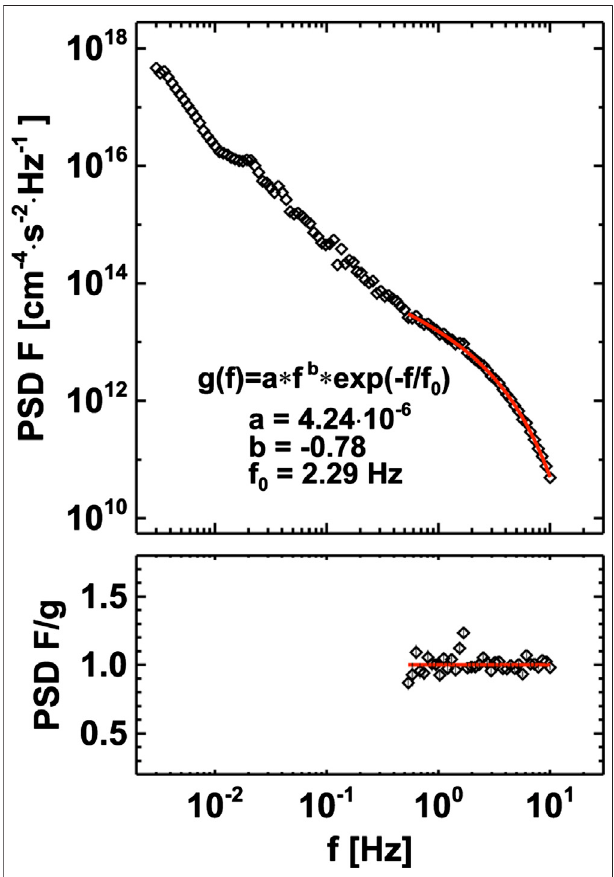
FIGURE 7 | Upper plot: The power spectral density of the ion fl ux downstream of a particularly strong IP shock detected at Spektr-R on September 12, 2014. The red line shows the fi t by an exponentially truncated power-law model function, g ( f ) . Lower plot: The ratio of the measured spectrum, PSDF , and the resulted fi t, g . Image adapted from [104] and reproduced by permission of the